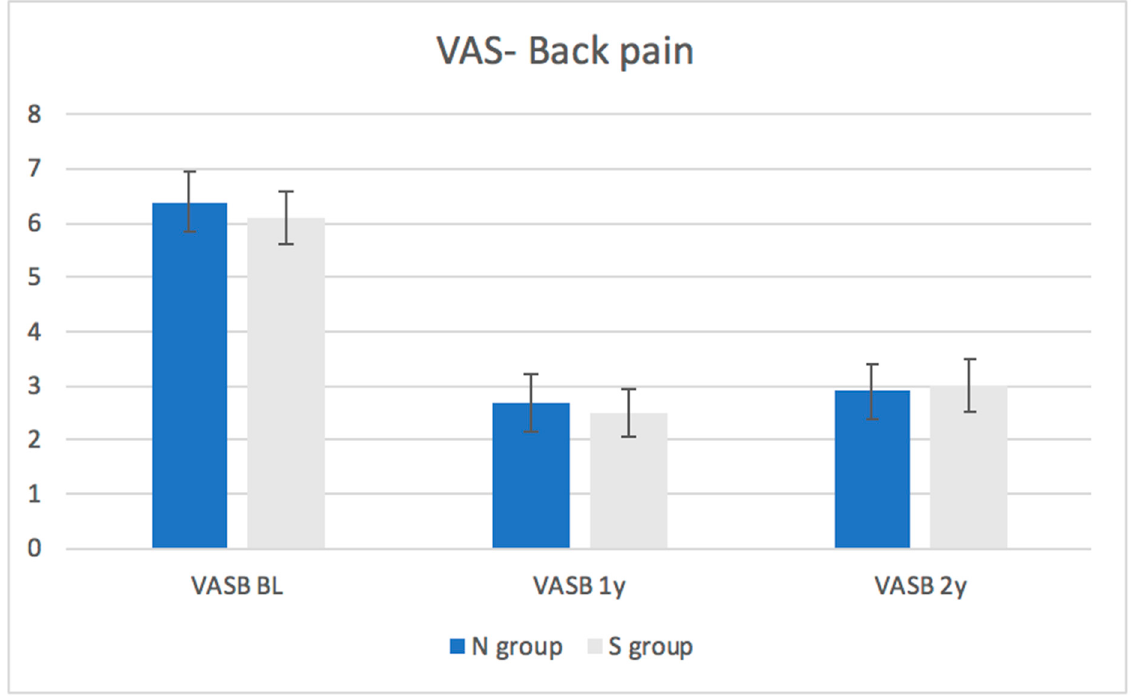
Figure 2. Changes in the visual analogue scale (VAS) for back pain in each group throughout the follow-up period.